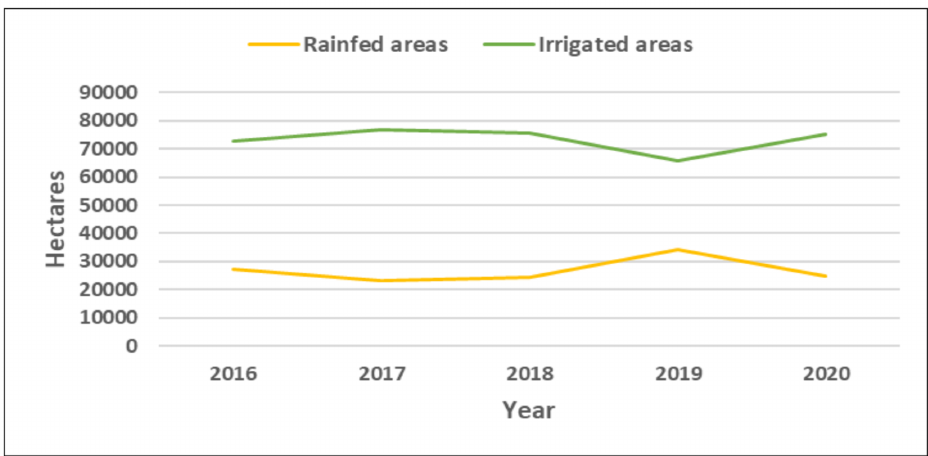
Figure 9. Trends in the irrigated area versus rainfed area in in Mpumalanga Province from 2016 to